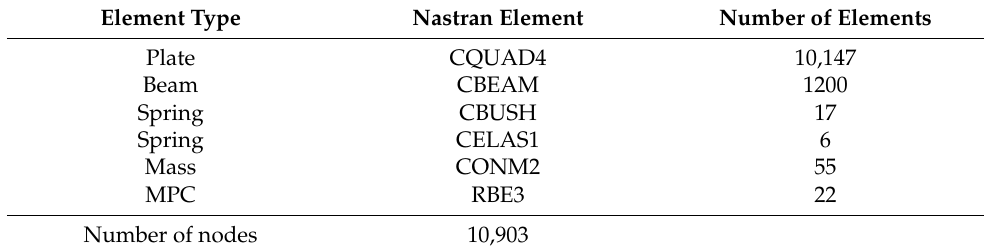
Figure 5. MiniWoT finite element model overview. Table 1. FE model elements and